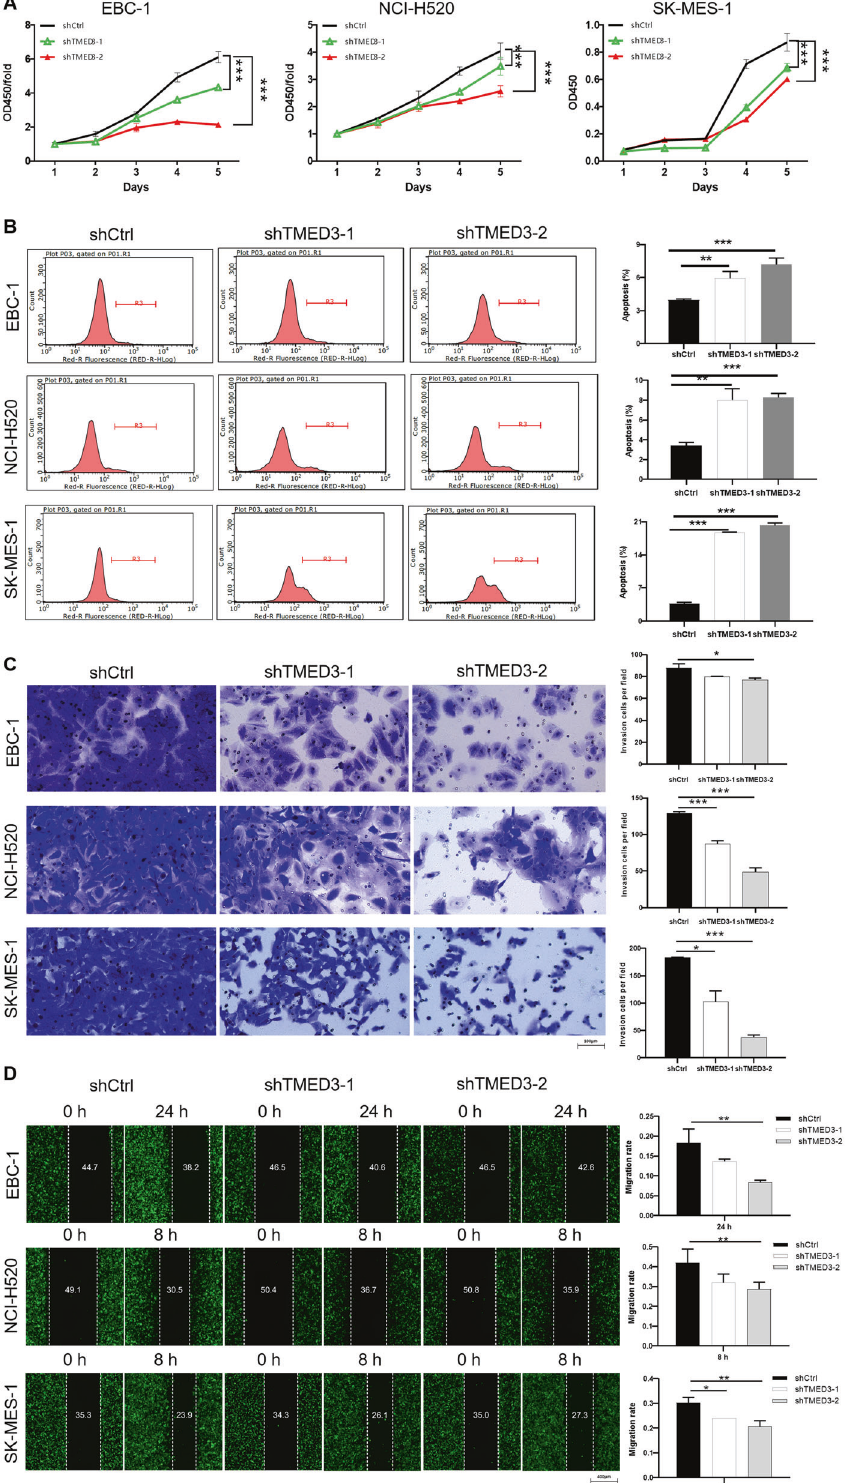
Fig. 2 The effect of TMED3 on cell proliferation, apoptosis, invasion, migration, and apoptosis/EMT-related proteins in LUSC. A MTT assay was used to evaluate the effect of TMED3 knockdown on proliferation of EBC-1, NCI-H520, and SK-MES-1 cells. B The effect of TMED3 knockdown on apoptosis of EBC-1, NCI-H520, and SK-MES-1 cells was evaluated by fl ow cytometry. C The changes of TMED3 knockdown on the invasion of EBC-1, NCI-H520, and SK-MES-1 cells were detected by the Transwell experiment (200× magni fi cation: scale bar = 100 μ m). D The would-healing assay was used to evaluate the effect of TMED3 knockdown on migration of EBC-1, NCI-H520, and SK-MES-1 cells.